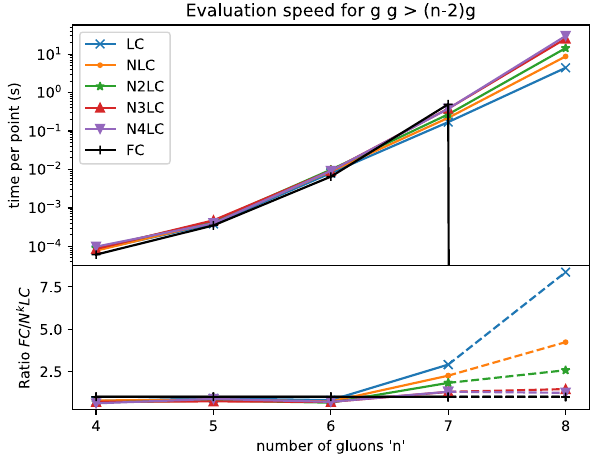
Fig. 10 Top: Speed of the process gg → ( n − 2 ) g for each colour ordering and gluon multiplicity. FC corresponds to standard MG5aMC (version 2.9.2, for standalone essentially equivalent to the latest version 3.4.1). Bottom:RatioofthespeedusingstandardMG5aMCtousingthe newcodeforeachcolourordering.StandardMG5aMCcannotcalculate gg → 6 g , so the right-most ratio speeds instead contains the N5LC BG speed on the denominator to show the effects of colour ordering and obtain an estimate for the true speed increase. Speed tests done on a MacBook Pro 2020 CPU i5-8257U